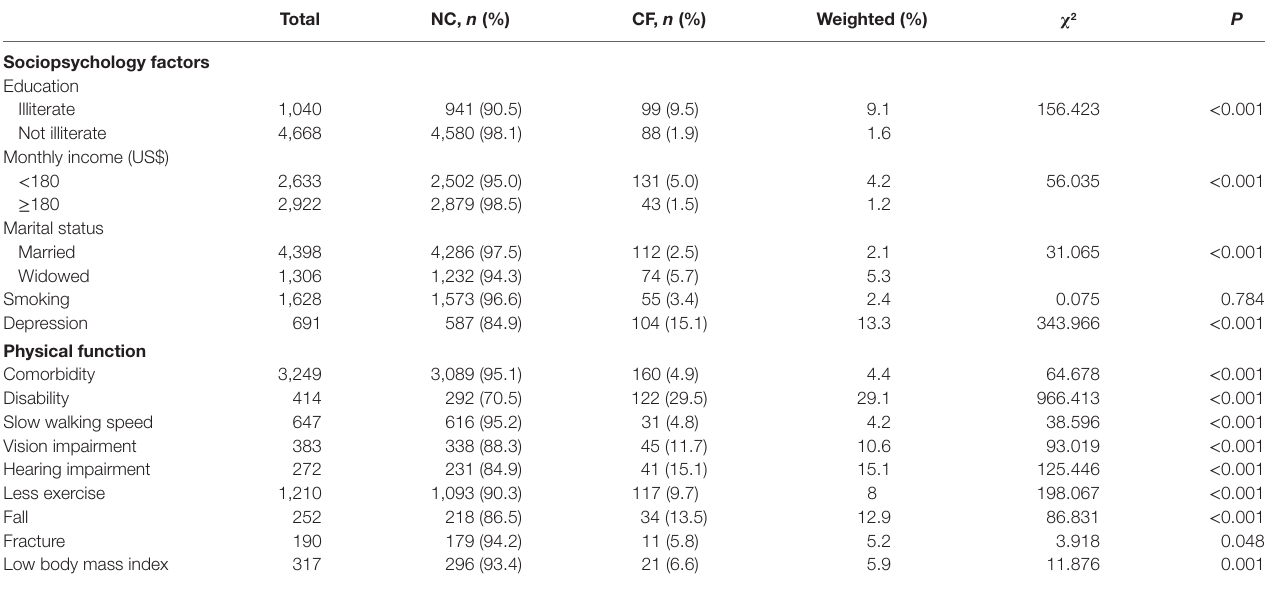
TaBle 1 | Effect of sociopsychology factors and physical function on cognitive frailty (CF). Total nc, n (%) cF, n (%) χ